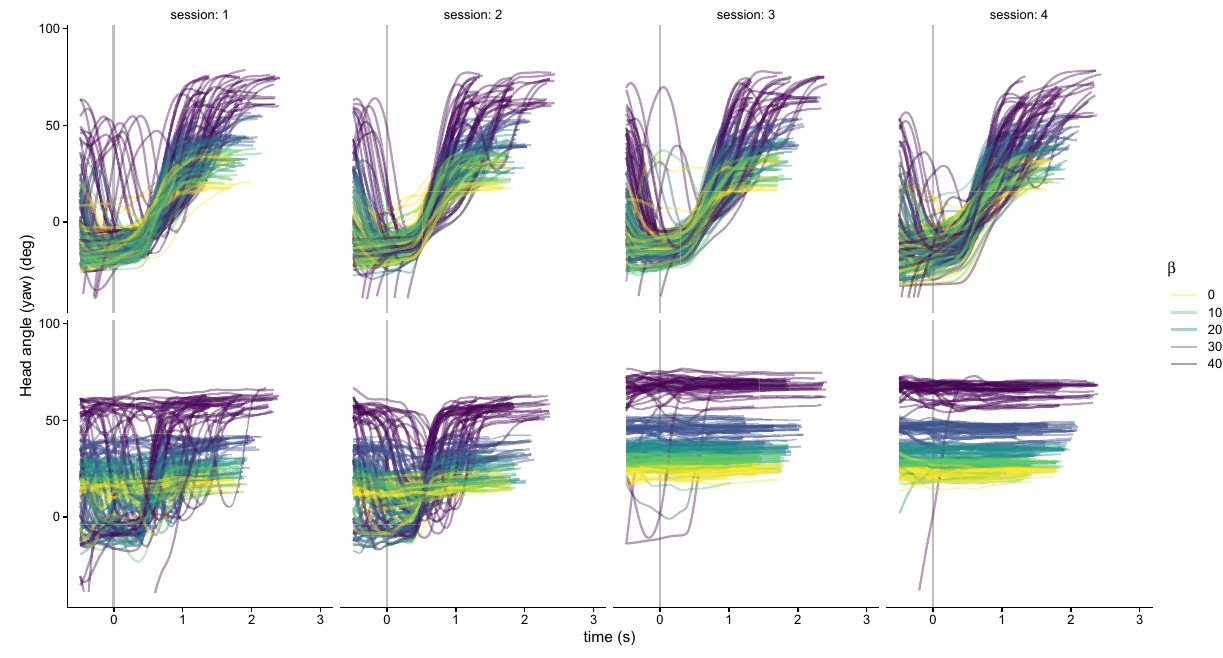
Figure 2. Examples of two participants (#1 and #5 in Fig. 3; bottom and lower panels, respectively) as a function of time. The lines show the Head angle (yaw) for the individual trials of each session (different columns) of the delayed feedback condition. The yaw values have been normalized for the two directions. A yaw angle of 0° corresponds to the head oriented straight-ahead [e.g. looking at (0, 15) from (0, 5)]. The vertical line denotes the stimulus motion onset. The participant in the upper panels always tracks the target’s trajectory with the head, while the participant in the bottom panels initially interleaves two tracking strategies in sessions 1 and 2, and finally fixates on the end-point of the trajectory (end-point tracking strategy). The different colors code the approaching angle β .